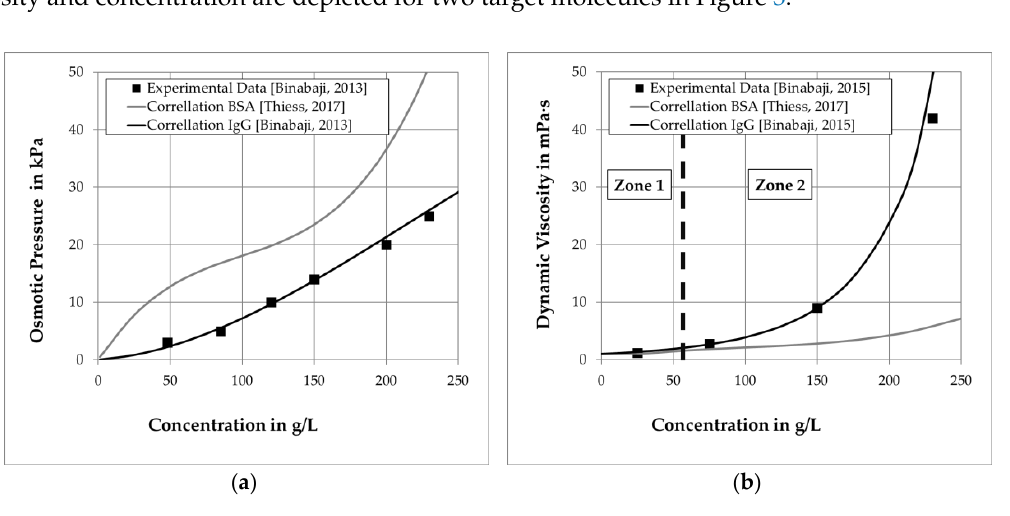
Figure 3. Dependency of process variables on protein concentration ( a ) osmotic pressure [1,49] and ( b ) dynamic viscosity [1,12].